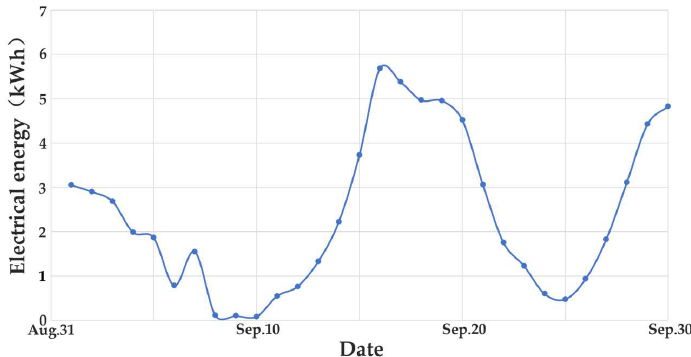
Figure 6. Monthly distribution of tidal power